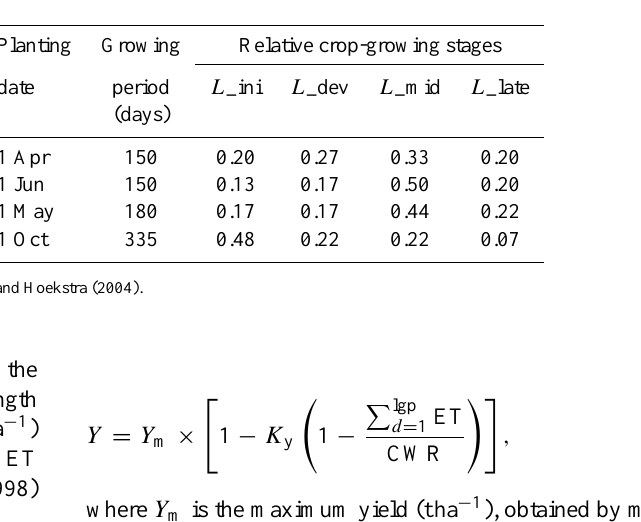
Table 1. Crop characteristics for maize, soybean, rice and wheat in the Yellow River basin.